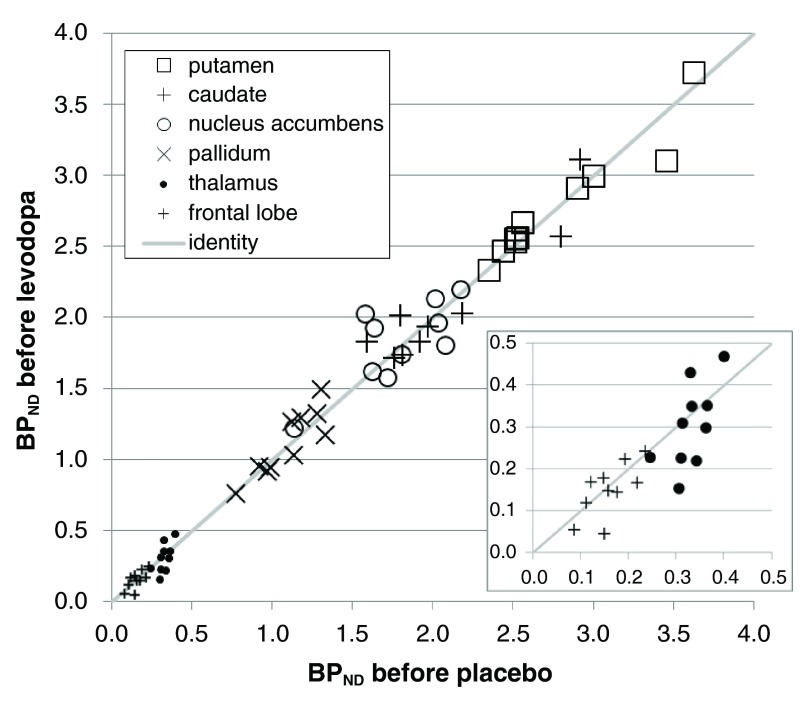
Stability of baseline binding between scan days in the
a priori VOIs.BP
NDs from the first scan of each day are plotted for all 10 subjects, with the BP
ND from the pre-placebo scan on the horizontal axis and from the pre-levodopa scan on the vertical axis. For the paired VOIs the mean of the left and right BP
ND is used. The diagonal line is the line of identity. The inset shows an enlarged view of the data from the frontal lobe and thalamus VOIs.